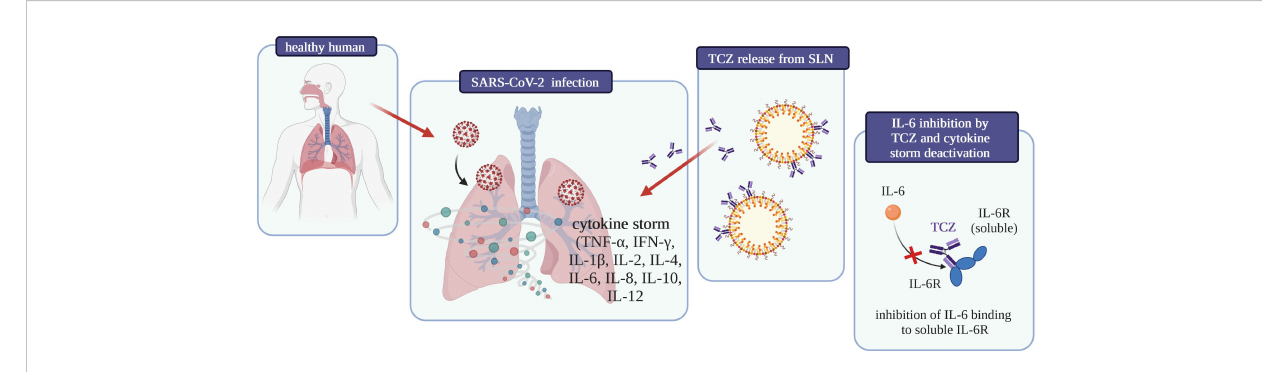
FIGURE 5 Graphical summary of the in fl uence on COVID-19 treatment of tocilizumab-coated solid lipid nanoparticles [own